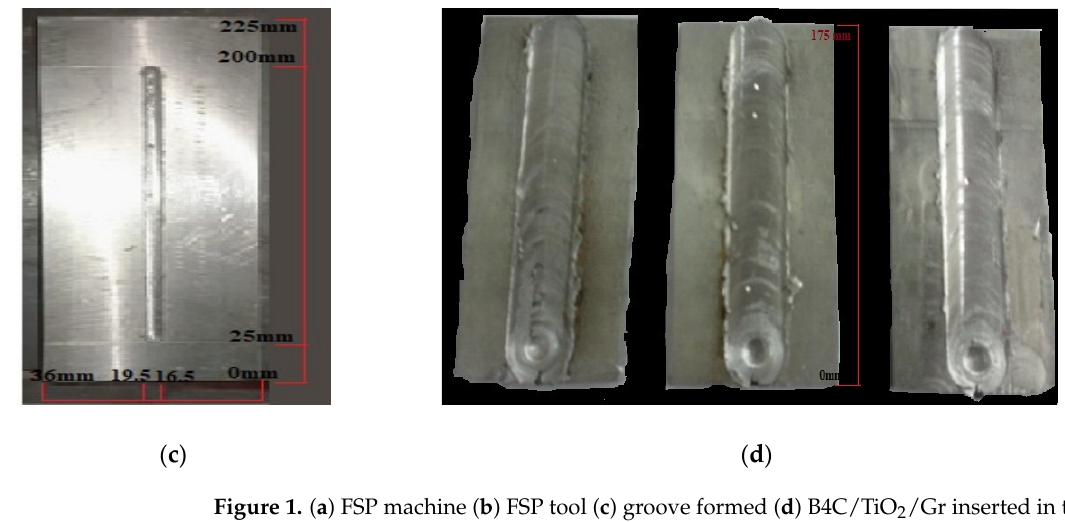
Figure 1. ( a ) FSP machine ( b ) FSP tool ( c ) groove formed ( d ) B4C/TiO 2 /Gr inserted in the groove on the substrate material.